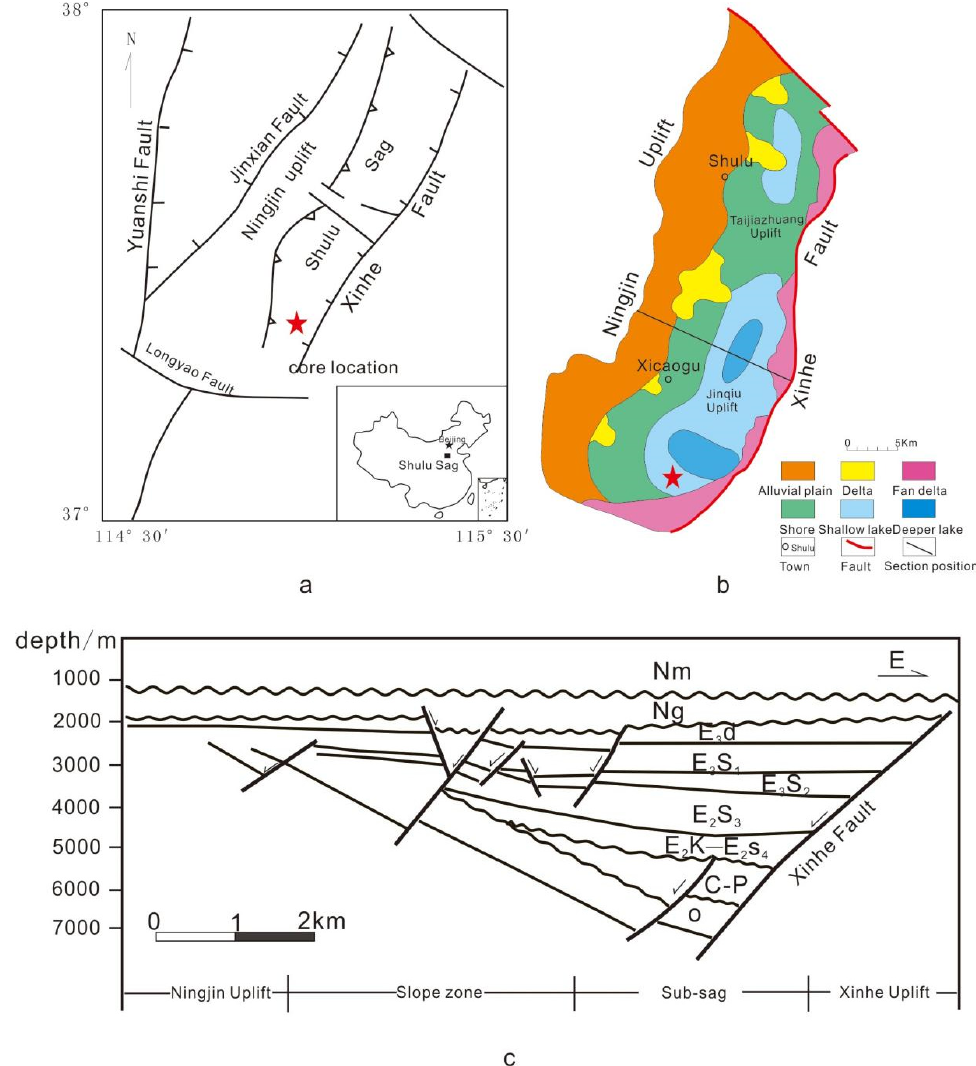
Figure 1. ( a ) Simplified tectonic map and location of the Shulu Sag, Bohaiwan Basin. ( b ) Outline map showing the structural units of the Shulu subbasin. ( c ) Cross section of geological